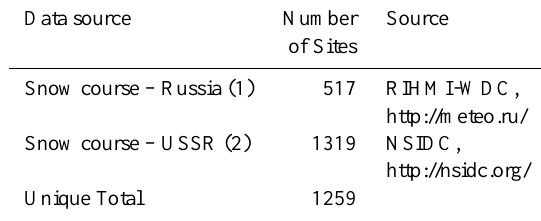
Table 1. Sources of snow density